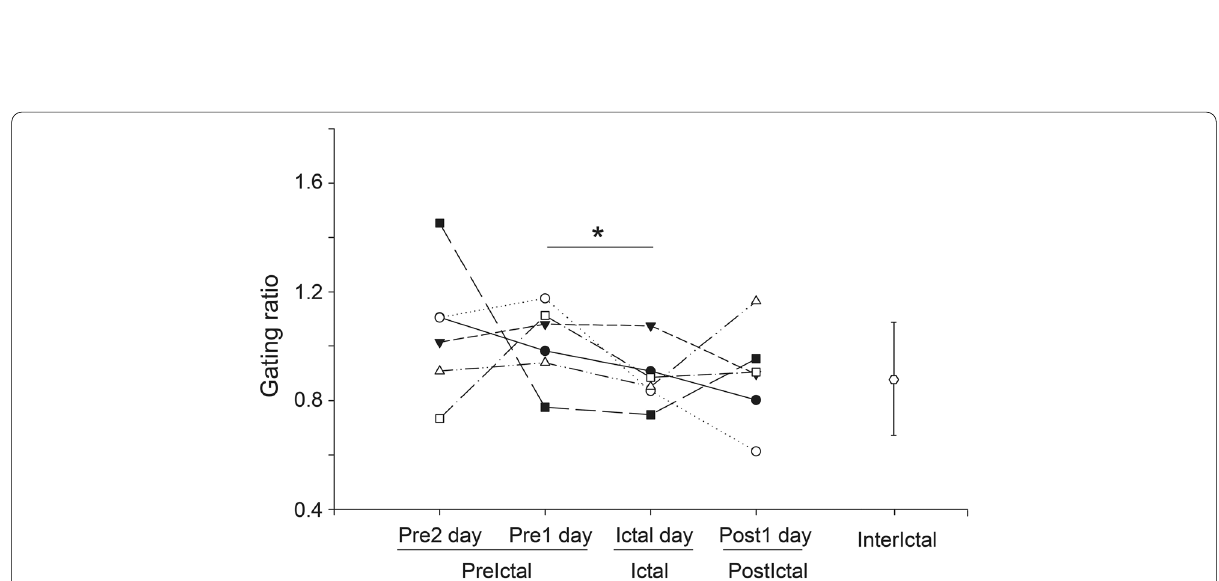
Fig. 8 S1 inhibition during migraine cycle. Differences in S1 gating ratio among migraine cycles ( n and Interictal ). *, P < 0.05; S1, primary somatosensory cortex; Pre2 , 24–48 h before headache onset; Pre1 , within 24 h before headache onset; Ictal , during migraine attack; Post1 , within 24 h after headache